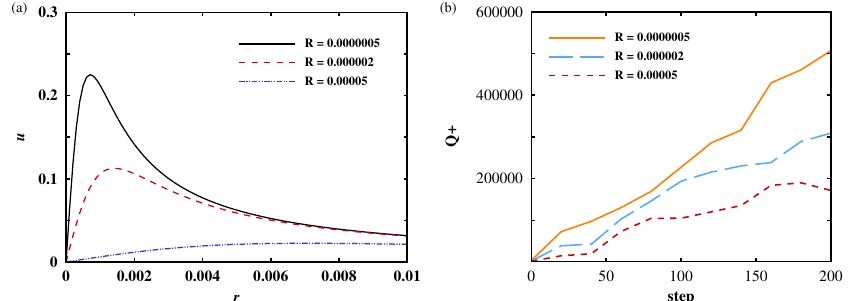
Figure 8. ( a ) The velocity profile induced by a vortex segment with different R ; r is the distance between the inquired position and the vortex segment. ( b ) Number of tracer particles’ position with positive Q -criterion.